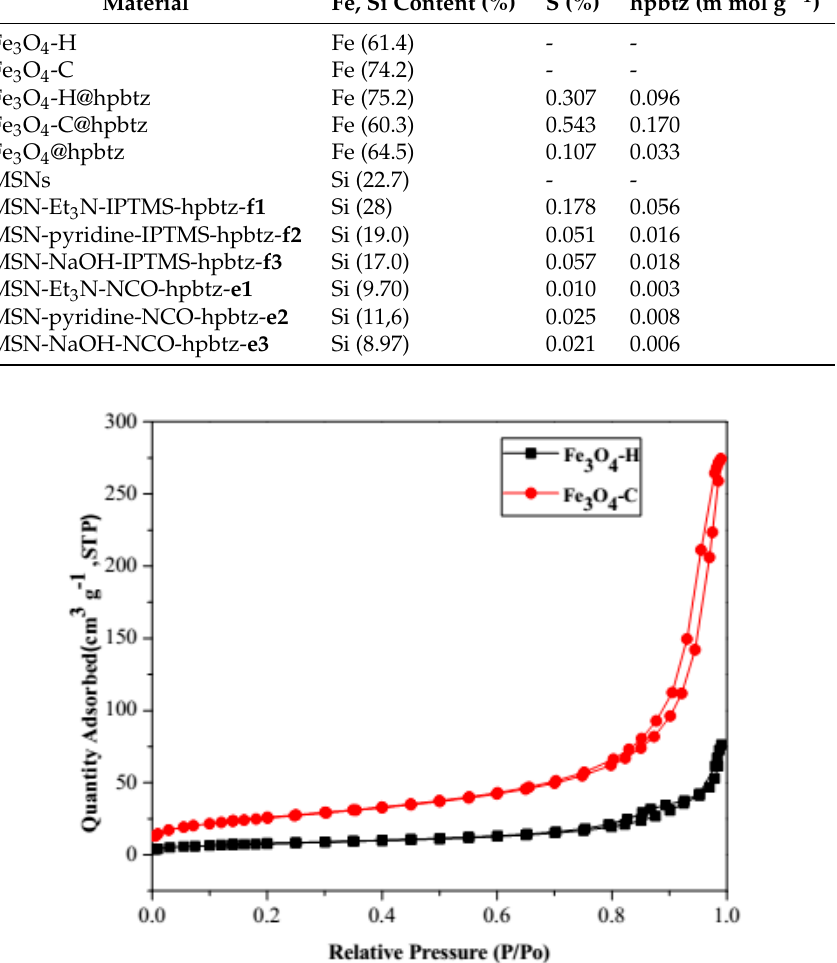
Figure 4. Nitrogen adsorption/desorption isotherms of MNPs (Fe 3 O 4 -H and Fe 3 O 4 -C). For both materials, type III isotherms are exhibited.